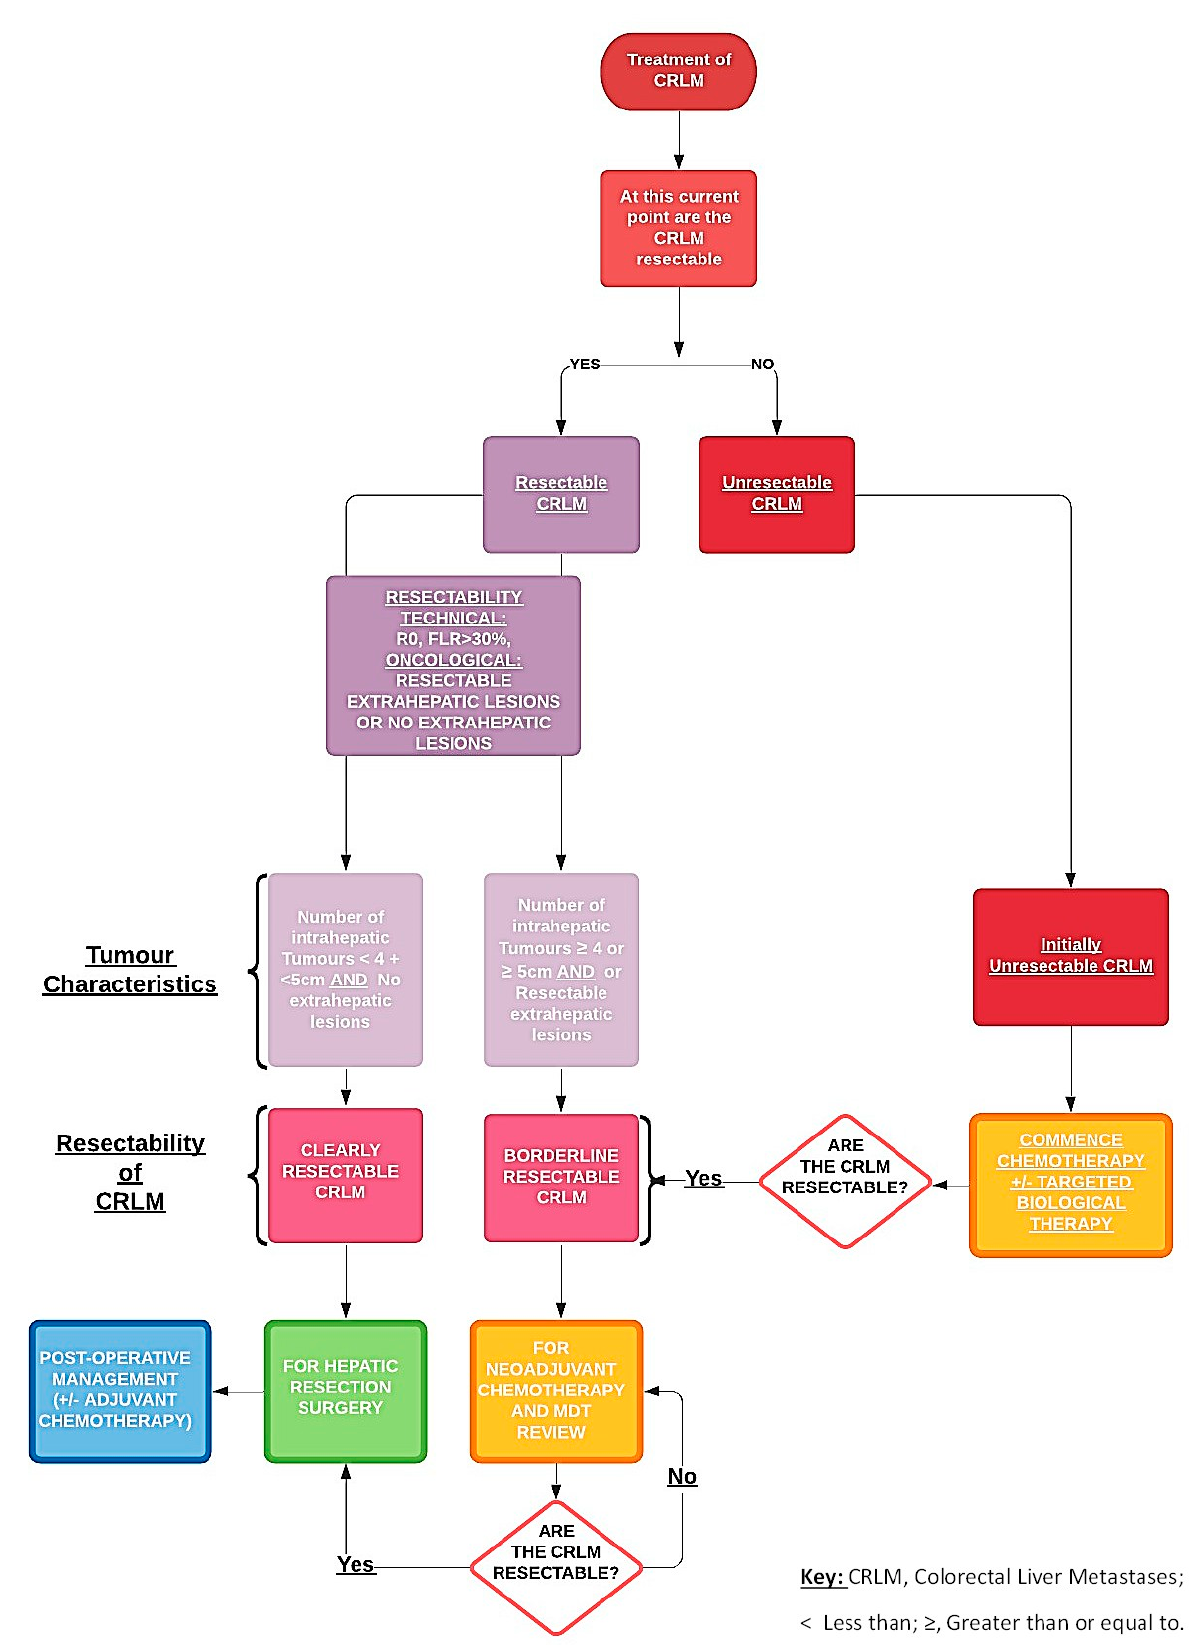
Figure 1. Pathway of managing resectable and unresectable colorectal liver metastases.